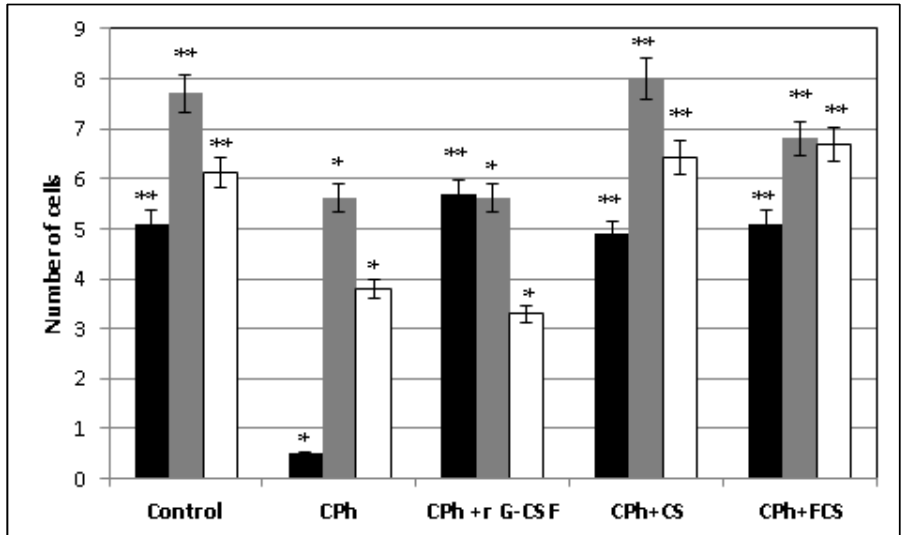
Figure 2. Hematological parameters of mice with cyclophosphamide (CPh)-induced immunosup- pression after treatment with recombinant granulocyte colony-stimulating factor (r G-CSF), chon- droitin sulfate ( CS ) and fucosylated chondroitin sulfate ( FCS ) (mean ± SD). ■ WBC × 10 6 /mL, ■ RBC × 10 9 /mL, □ platelets × 10 8 /mL. * p < 0.05 vs. control, ** p < 0.05 vs. CPh.